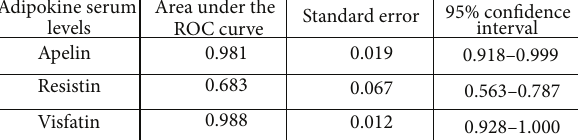
Figure 2: Comparison of receiver operating characteristic (ROC) curves for apelin, resistin, and visfatin between children with atopic dermatitis and healthy